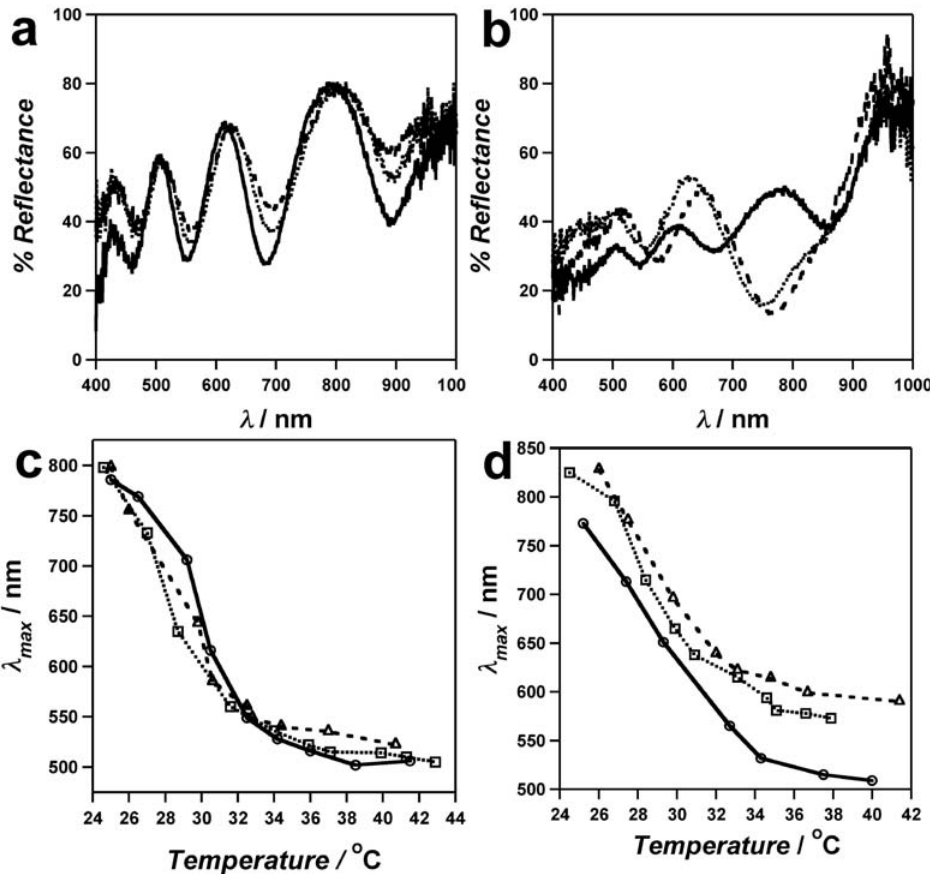
Figure 3. Reflectance spectra from three randomly selected areas of an etalon fabricated using the ( a ) “Paint-on” method and the ( b ) overnight drying method. Plots of λ temperature for randomly selected regions (the three different regions in the spectra in (a,b) of films fabricated using the ( c ) “Paint-on” method and the ( d ) overnight drying method. All data were collected for in pH 3 water (I.S. = 1) solution. Reprinted with permission from [13] Copyright (2011) American Chemical